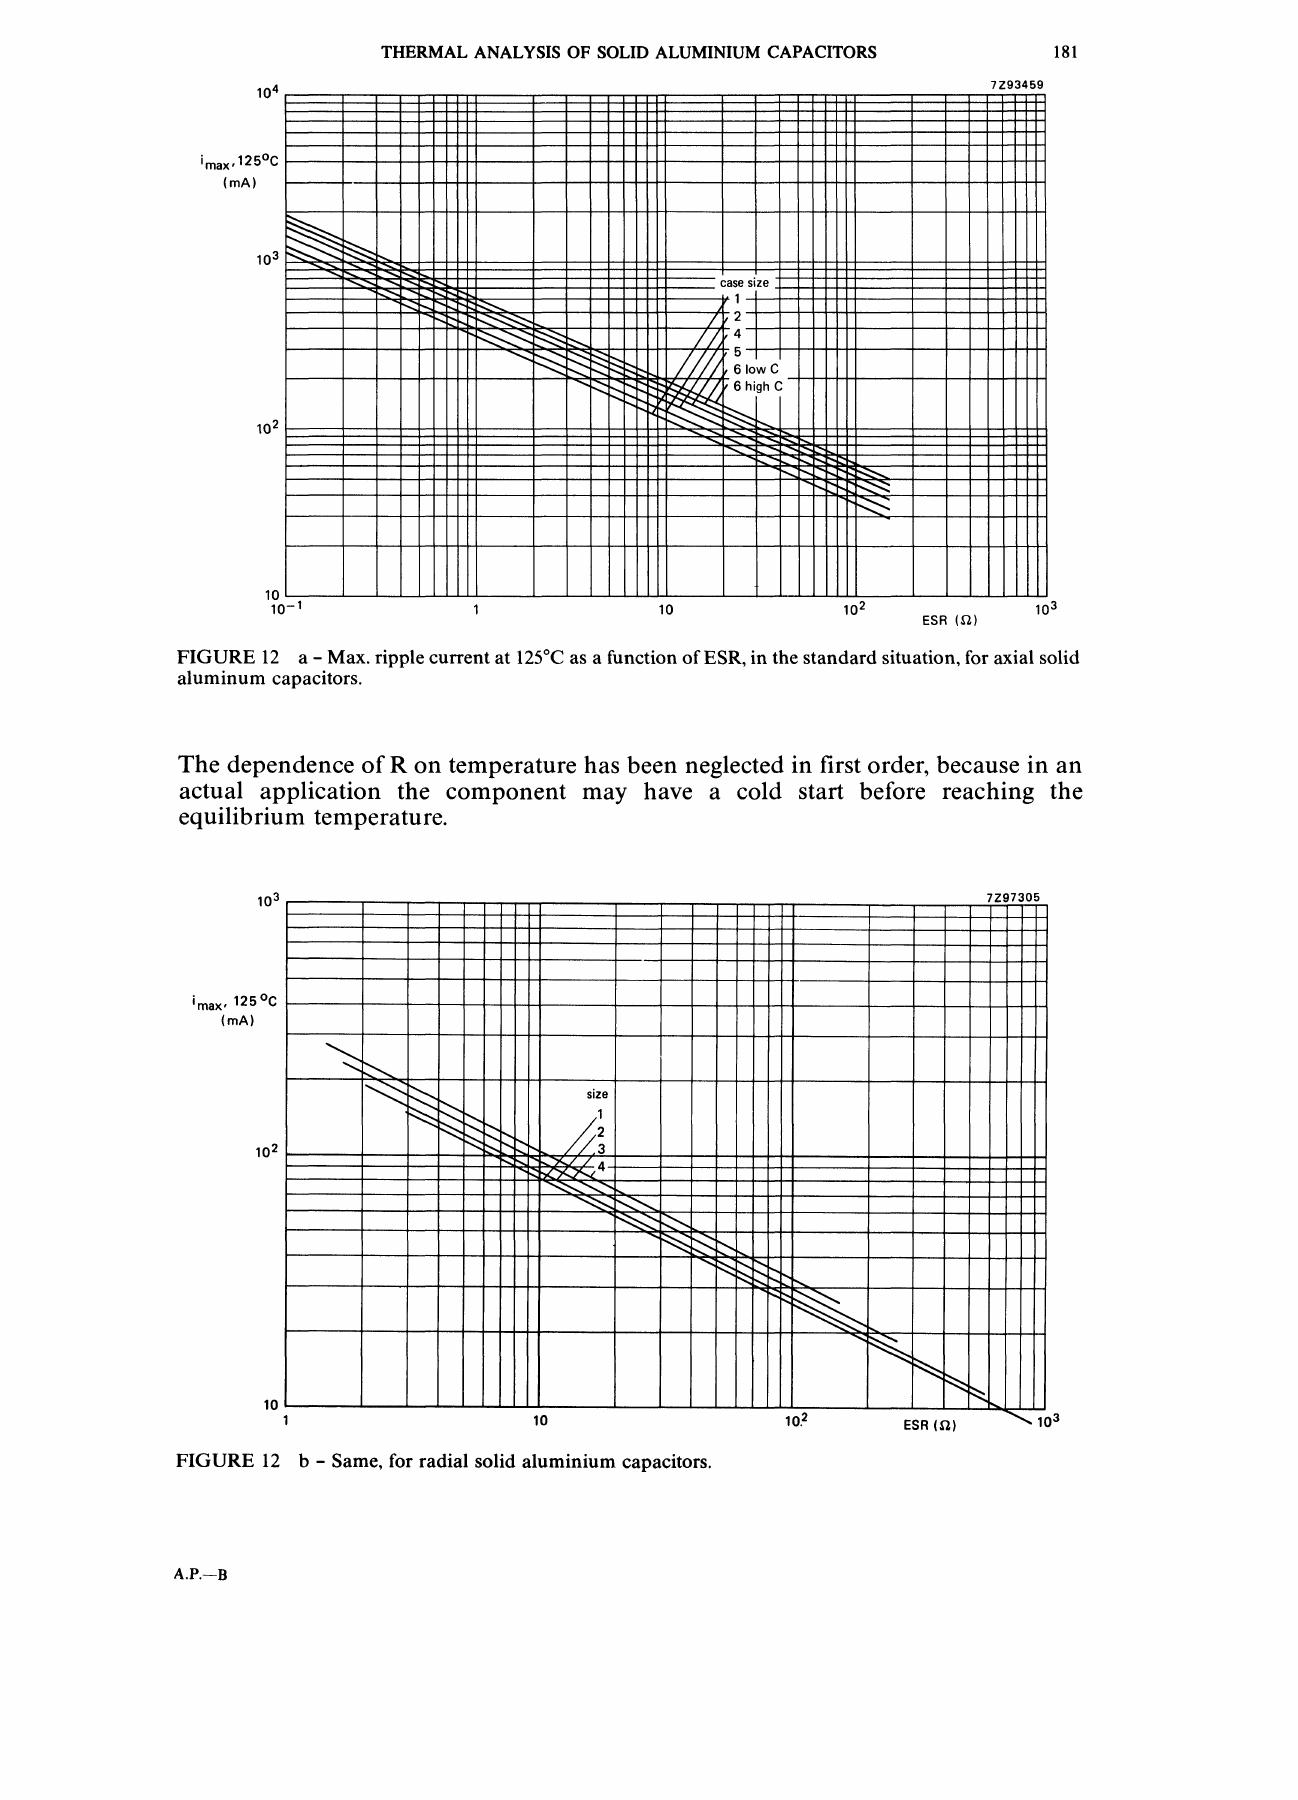
FIGURE 12 b Same, for radial solid aluminium